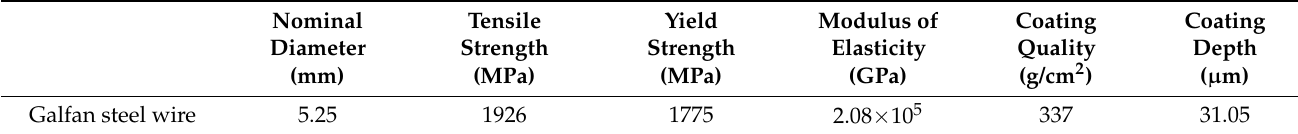
Table 2. Parameters of steel wire